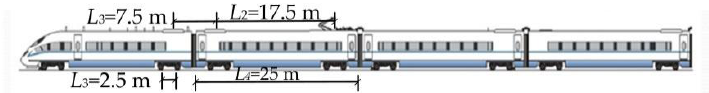
Figure 14. Sketch of characteristic lengths of a high-speed train.